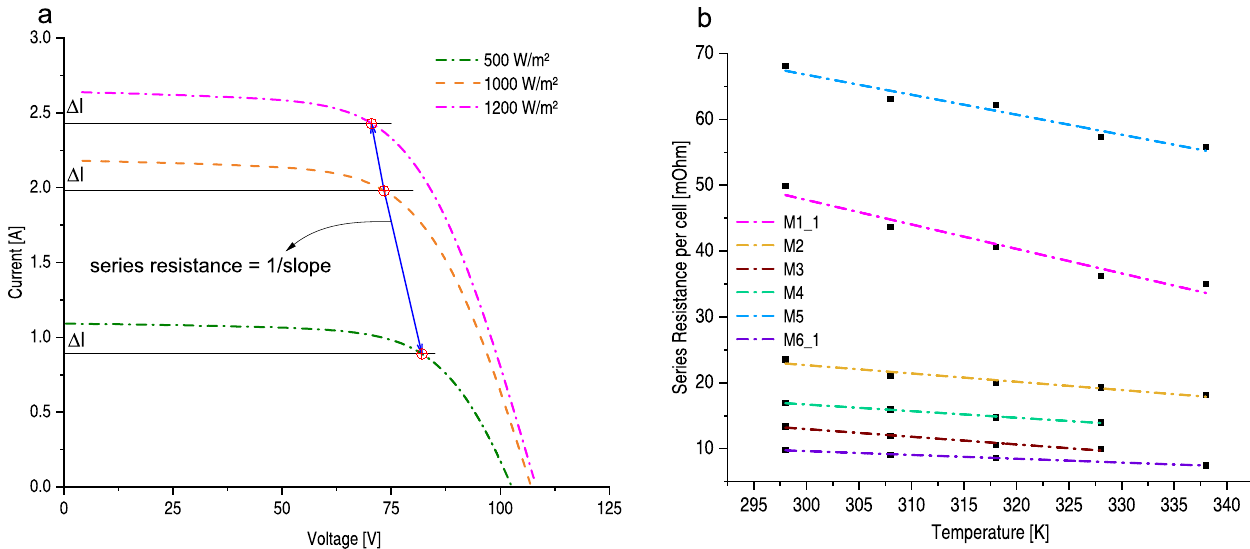
Fig. 3 Determination of series resistance and its behaviour with temperature. a Determining series resistance using IV curves under different illumination intensities at 25 °C. b Variation in series resistance of different CIGS cells with temperature. Dotted lines denote the linear fi t of the